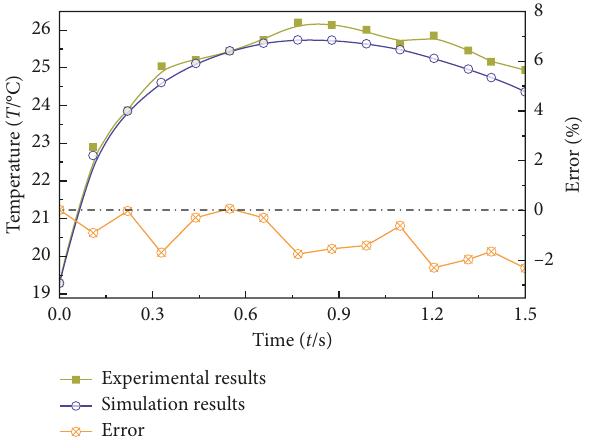
Figure 7: Comparison of experimental and simulated results.